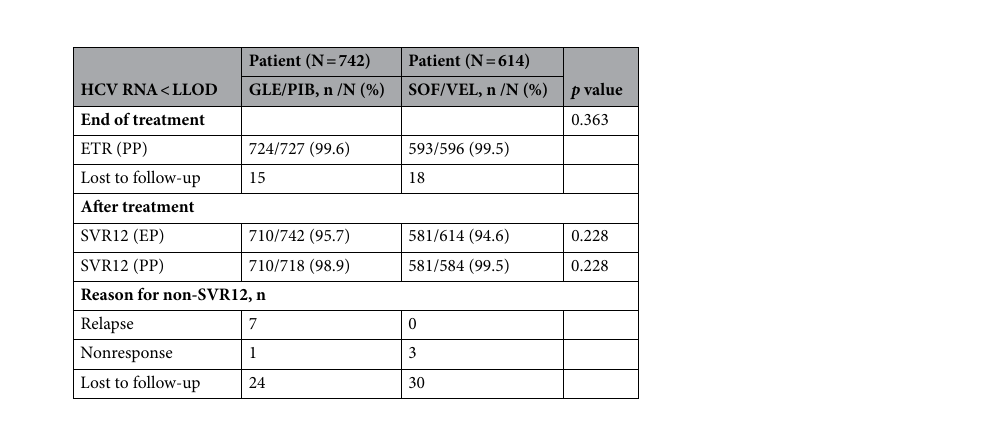
Table 3. Virologic responses. EP evaluable population; GLE/PIB glecaprevir/pibrentasvir; HCV hepatitis C virus; LLOD lower limit of detection; PP per-protocol population; RNA ribonucleic acid; SOF/VEL sofosbuvir/ velpatasvir; SVR12 sustained virological response 12 weeks after treatment